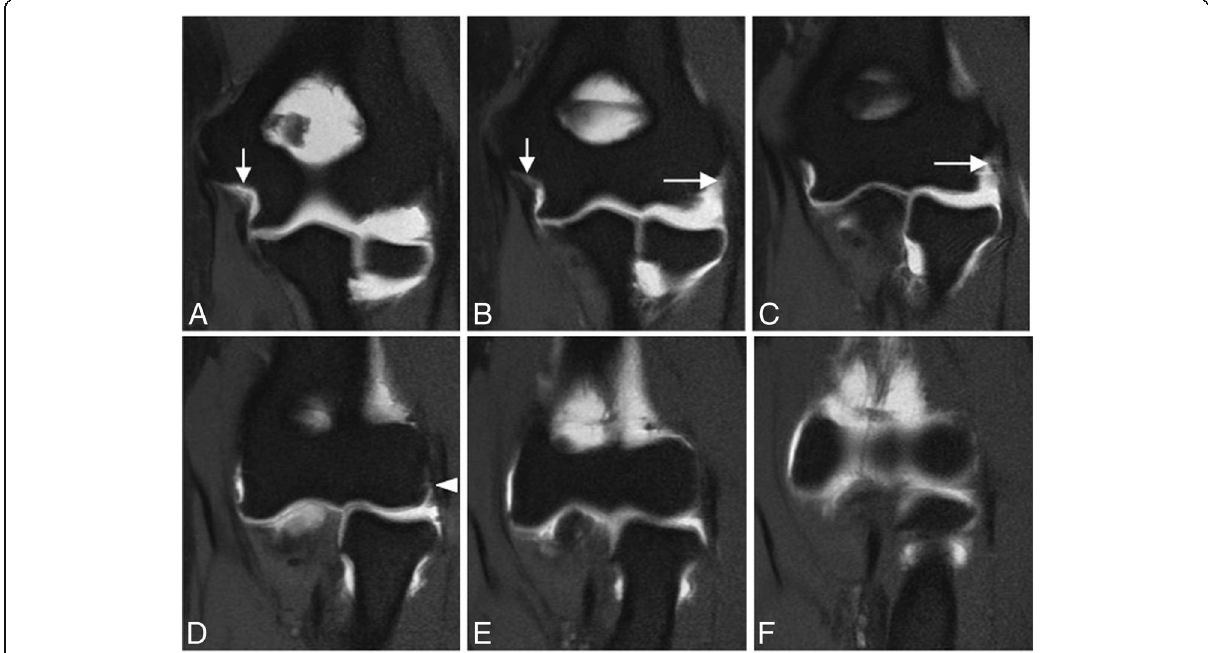
Fig. 26 Posterolateral rotatory instability, stage 3B. Consecutive coronal FS T1-weighted direct MR arthrographic images ( a – f ) showing a proximal partial-thickness tear of the anterior bundle of the medial collateral ligament complex (short arrows), proximal complete tear of the lateral ulnar collateral (long white arrows), and partial-thickness tear of the radial collateral ligament proper (white